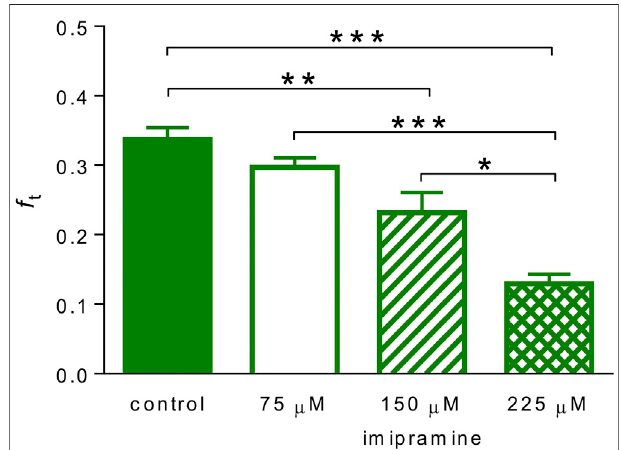
FIGURE 6 | Partial detubulation revealed by the new technique. Comparison of the fraction of the t-tubular membrane f t in control ventricular myocytes ( n = 21) and in ventricular myocytes partially detubulated using 75, 150, and 225 μ M imipramine ( n = 5, 8, and 8, respectively); *, **, and *** — statistical signi fi cance at p < 0.05, 0.01, and 0.001,